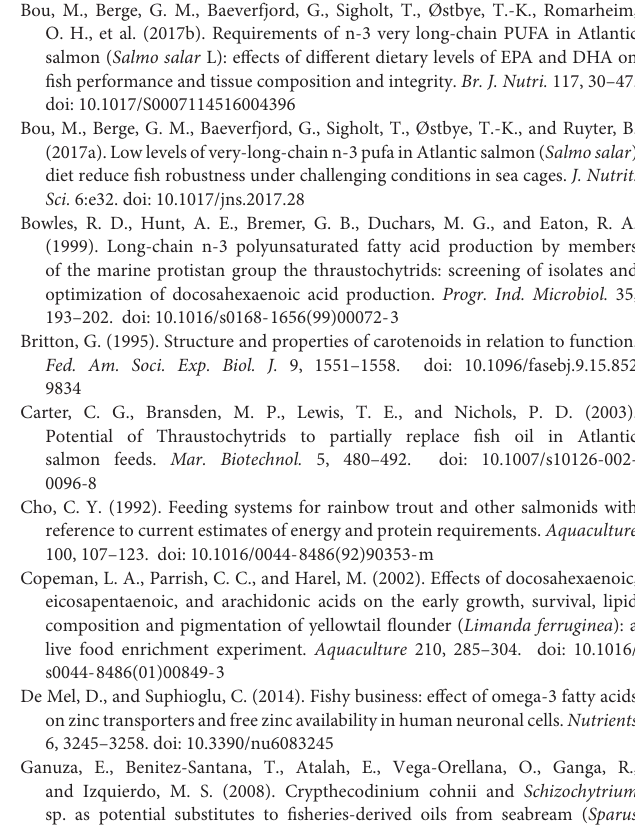
FIGURE S1 | Atlantic salmon were kept in tanks and fed in triplicate groups from parr through smoltification and further on to body weight of ca. 800 g three diets, containing fish oil (FO), S. limacinum biomass (ScB) or a mix of the two as EPA + DHA source. Fish were then mixed and moved to sea cages where there were fed in two triplicate groups either FO or ScB to